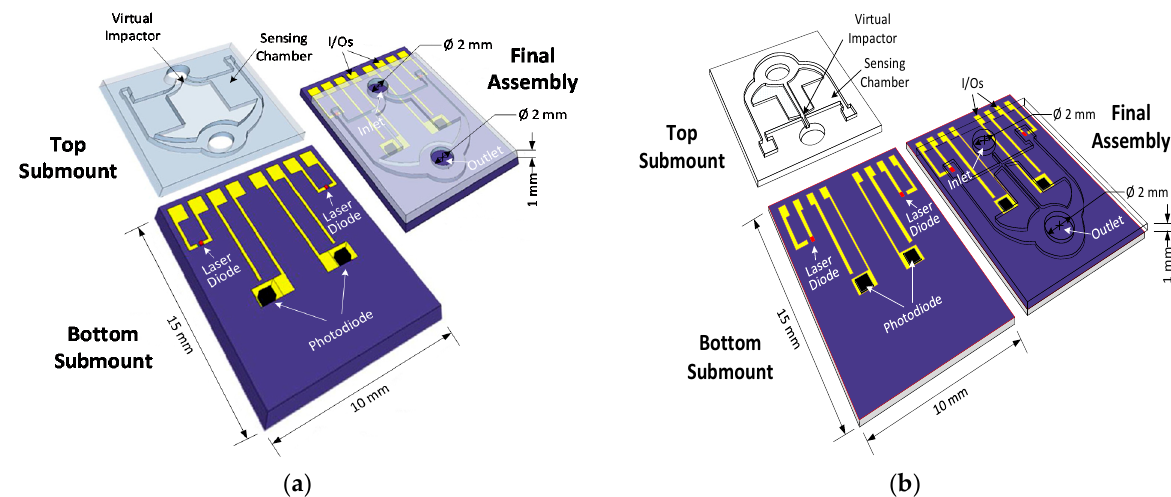
Figure 7. The schematic of the designed particle sensor; top submount is flipped over bottom submount, so as to overlap surfaces, as sketched in the final assembly. ( a ) The sensing unit of the second layout of silicon-based OPC. Adapted with permission from ref. [72]. © 2021 Elsevier; ( b ) The schematics of the third layout PM2.5 sensor. Adapted with permission from ref. [74]. © 2021 IEEE.